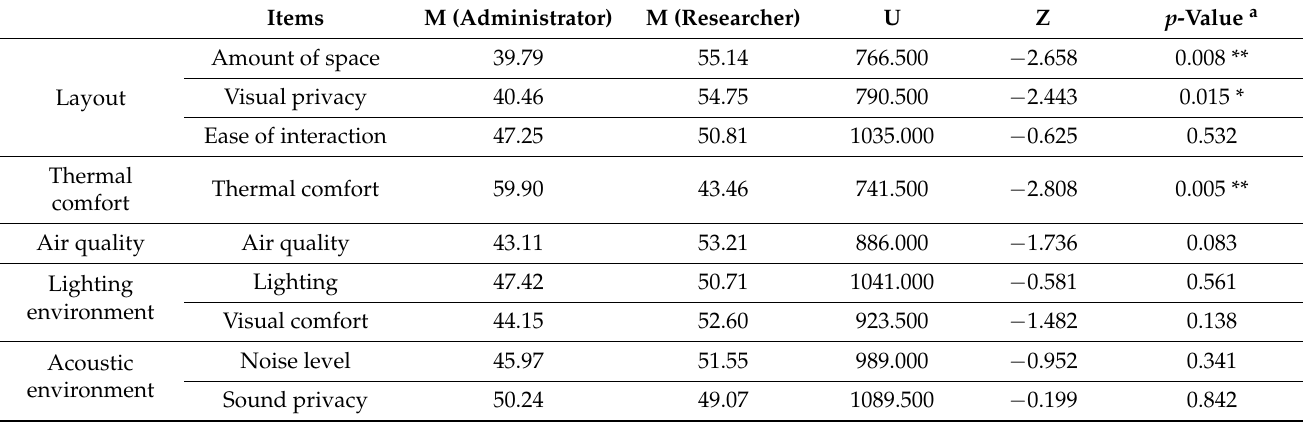
Table 10. Comparison of average satisfaction with